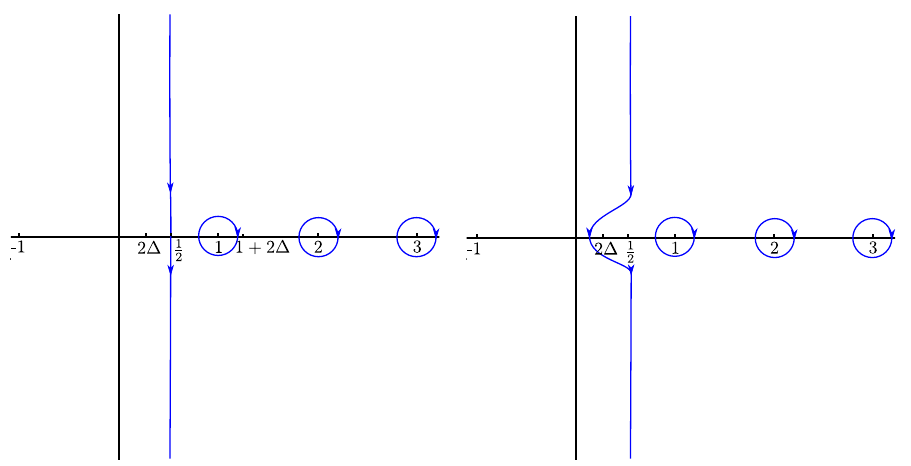
Figure 6 . Integration contours in the non-supersymmetric SYK model. The anti-symmetric chan- nel is on the left, the symmetric one is on the